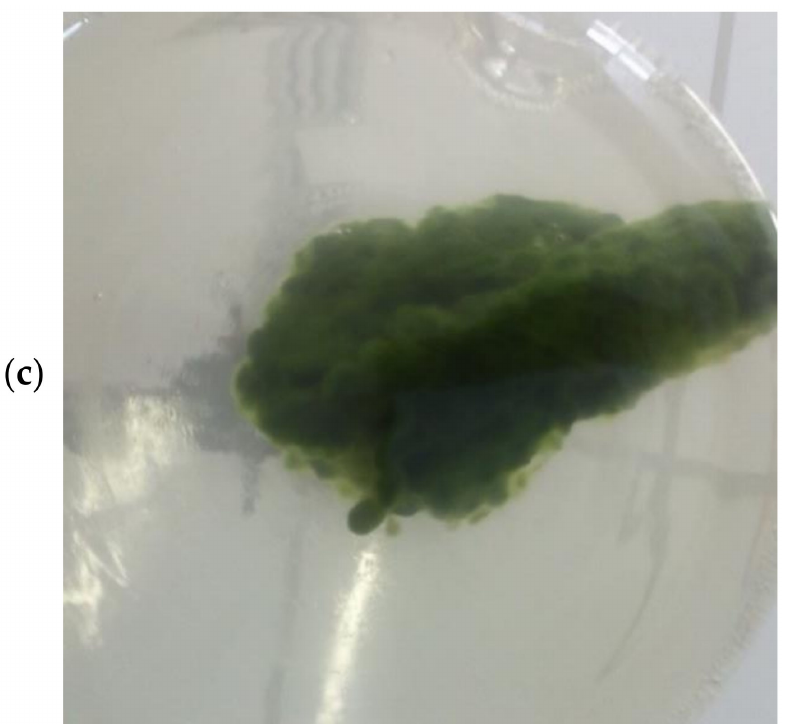
Figure 2. Lichen formation steps: ( a ) solo fungal mycelium; ( b ) fungal mycelium added to algae culture; ( c ) lichen-like structure after 108 h with algae cells adhering to fungal mycelium.